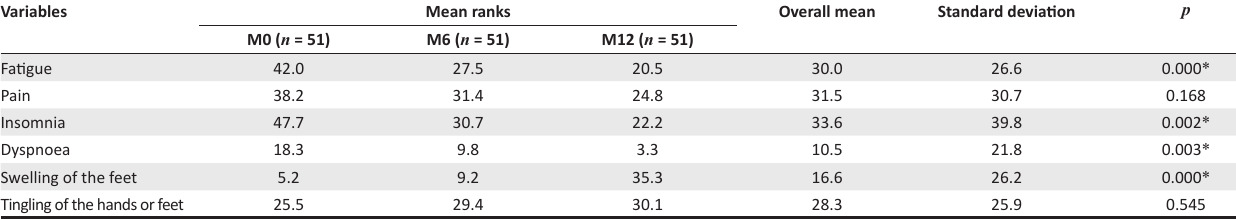
TABLE 4: General symptoms reported per group ( n = 153). Variables